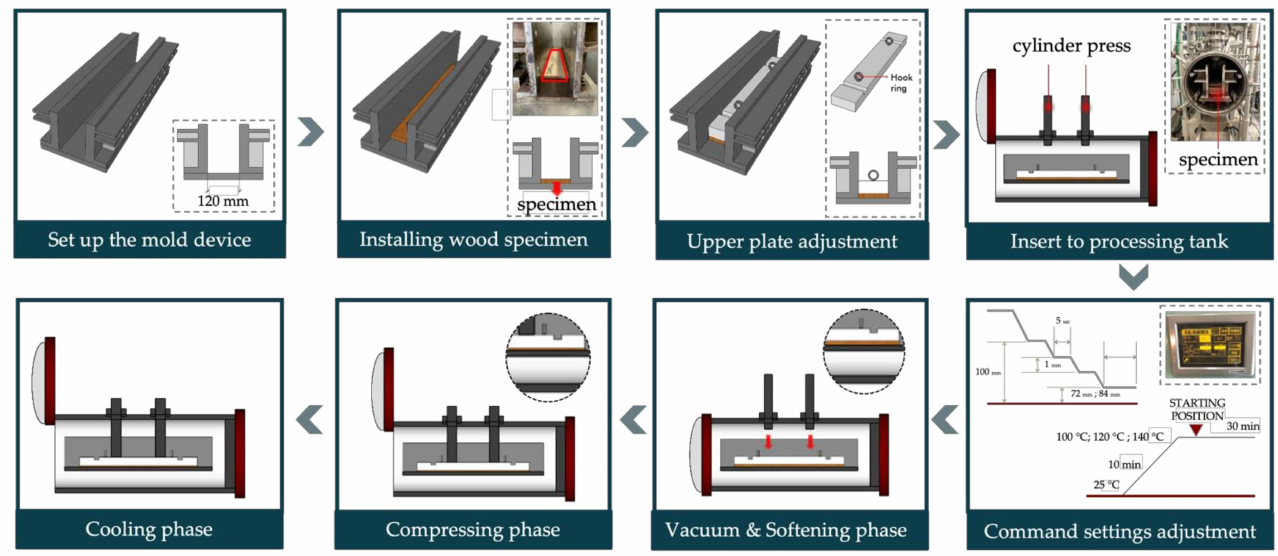
Figure 1. Schematic illustration of the high-temperature and -pressure process.